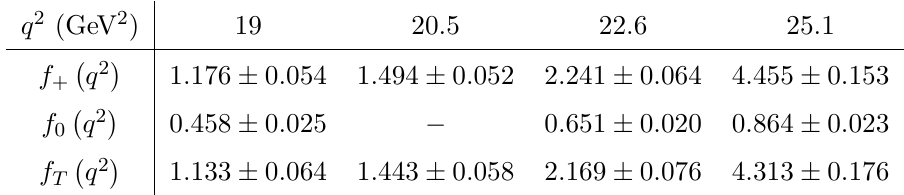
Table 1 . Synthetic datapoints for B → π transition form factors from Lattice MILC [12, 13] and corresponding correlations given in eq. (A.1).